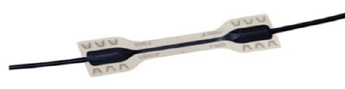
Figure 1. Weldable deformation sensor.